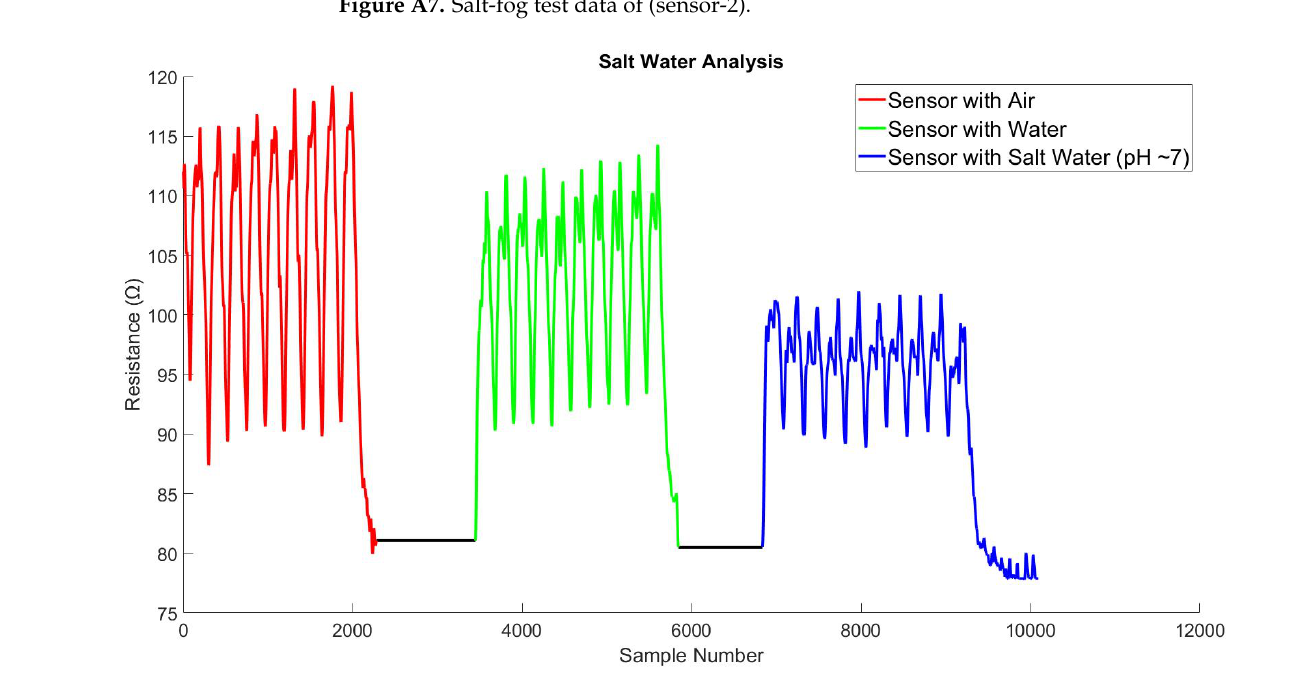
Figure A8. Salt-fog test data of